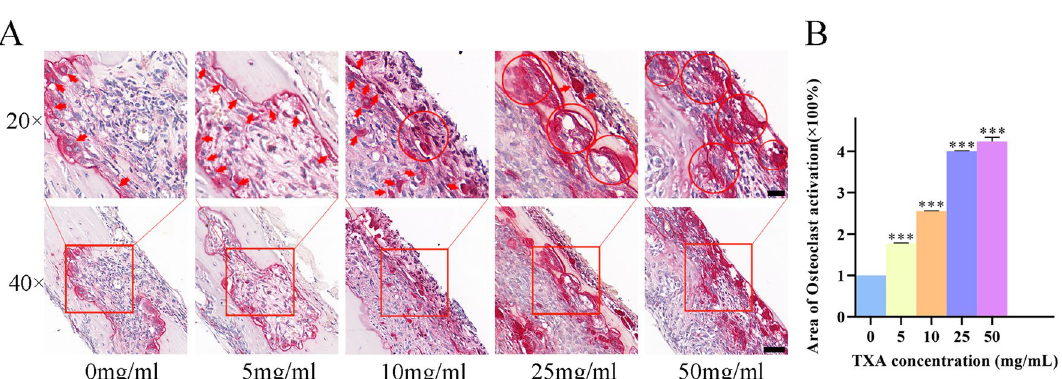
Figure 6. ( A ) Trap staining of skull slices after treatment with TXA at different concentrations 24 h after 3 injections. Scale bar: 50 μm (above) and 20 μm (below). ( B ) Quantification of osteoclast activation in skull slices. The results were quantified as the mean of three independent experiments and analysed by one-way ANOVA (* p < 0.05 indicates statistical